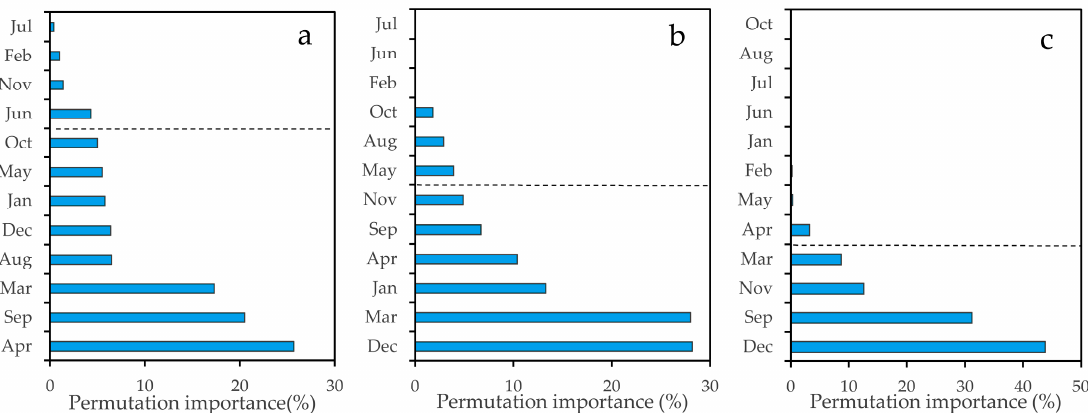
Figure 8. Months’ importance sorted in descending order with the permutation importance value. The month importance was determined by summing the permutation importance value of all bands in each month (from AICc-selected models. ( a ) Months’ permutation importance from the first time-series model (TS-1); ( b ) months’ permutation importance from the second time-series model (TS-2); ( c ) months’ permutation importance from the third time-series model (TS-NDVI). The sum of the permutation importance value from the months with two time-series models below exceeds 90% of the total, depicted by the gray dotted line.